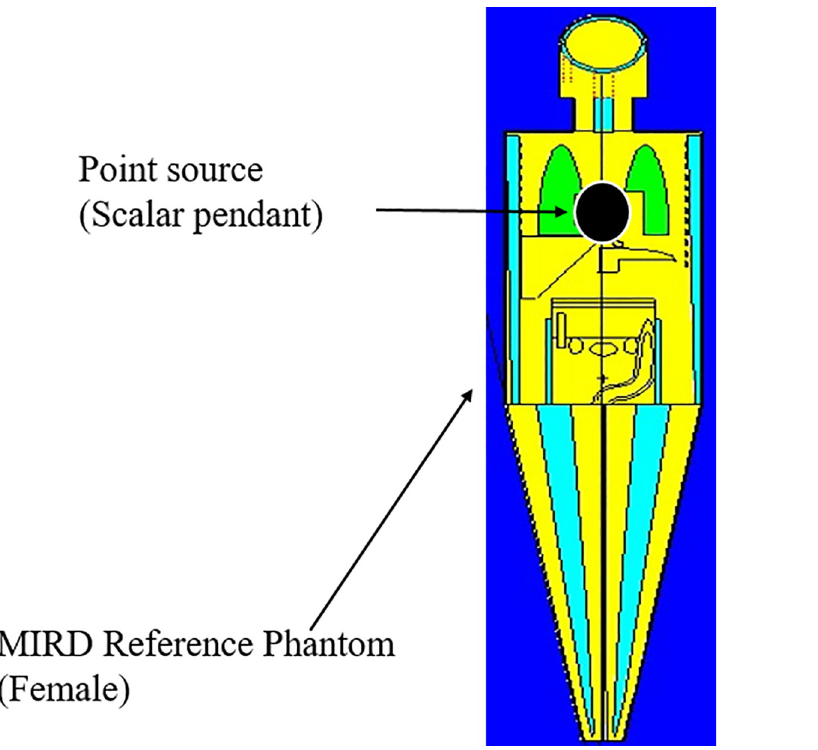
Fig 4. MIRD human phantoms for a scalar pendant, as used in MC